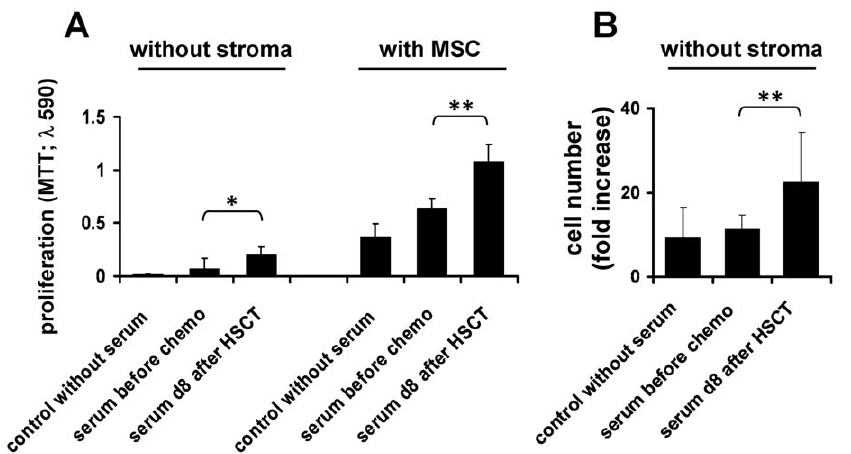
Figure 1. Serum after HSCT stimulates proliferation of CD34 + cells. Serum samples were taken before chemotherapy and eight days after autologous HSCT, when leukocyte counts are at a minimum. Serum was subsequently supplemented for in vitro expansion of CD34 + cells for 1 week either without stromal support or with co-culture of mesenchymal stromal cells (MSC). Analysis was either performed with the MTT-assay (A) or using a cell counter to determine fold-expansion rates (B). Serum from neutropenic patients significantly increased proliferation of HPC (* p , 0.05; ** p , 0.01; error bars represent SD).